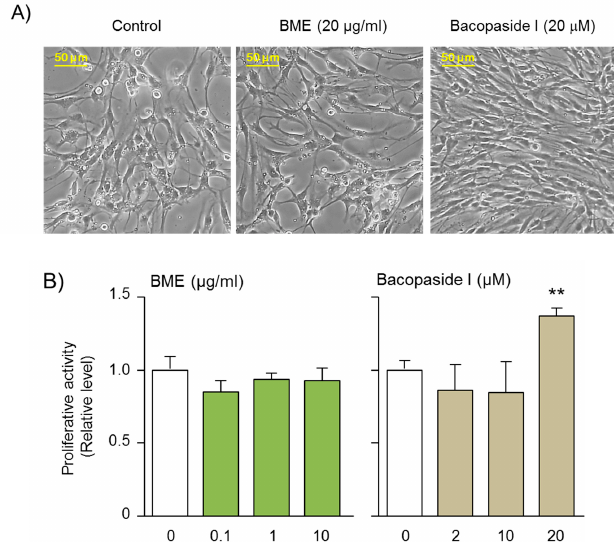
Figure 5. Effect of BME and bacopaside I, a major triterpenoid constituent of BME, on the proliferation of the NPCs. Cells were prepared from hippocampal dentate gyrus, as described in the Material and Methods section. After cultivating for 14–20 days, NPCs were harvested for subsequent replating and culturing in the growth medium in the absence or presence of different concentrations of BME and bacopaside I for assessment of cell proliferation by 3-(4,5-Dimethylthiazol-2-yl)-2,5-diphenyltetrazolium bromide (MTT) assay. A ) Typical images of NPCs cultured in the absence or presence of BME (20 μ g/ml) and bacopaside I (20 μ M). B ) Summarized data on NPC proliferation after incubation for 6 days with indicated treatments. Each data column represents the mean ± SEM from 4 separate experiments. ** p < 0.01, significantly different from the non-treated group.